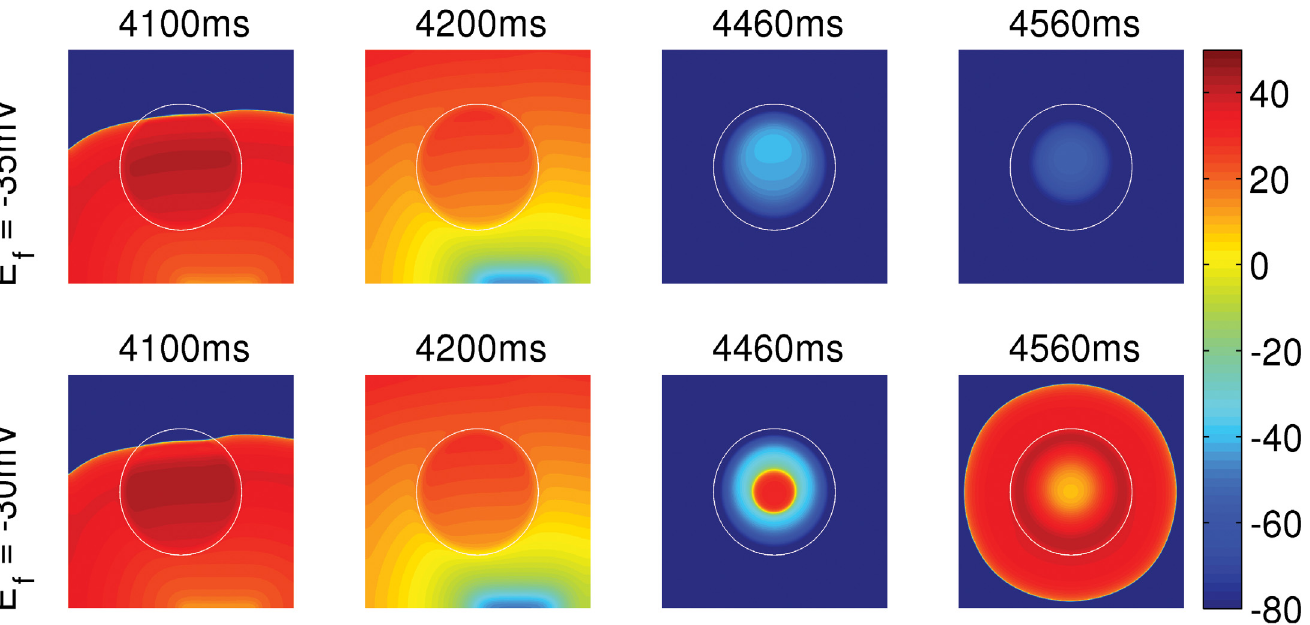
Fig 8. The dependence of PVC triggering on E f of the fibroblasts in an EAD myocyte-fibroblast clump. Pseudocolor plots of V m showing that an EAD myocyte-fibroblast clump, with R = 2.2 cm, triggers PVCs if E f = -30 mV (bottom panel), but is unable to trigger PVCs if E f is reduced to -35 mV (top